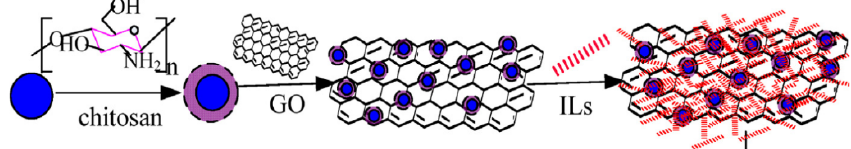
Figure 6. Synthesis route for preparation of GO–chitosan and GO–Chitosan–Ionic Liquid nanocomposites (Reproduced or adapted from ref. [33], with permission from Elsevier, 2020).